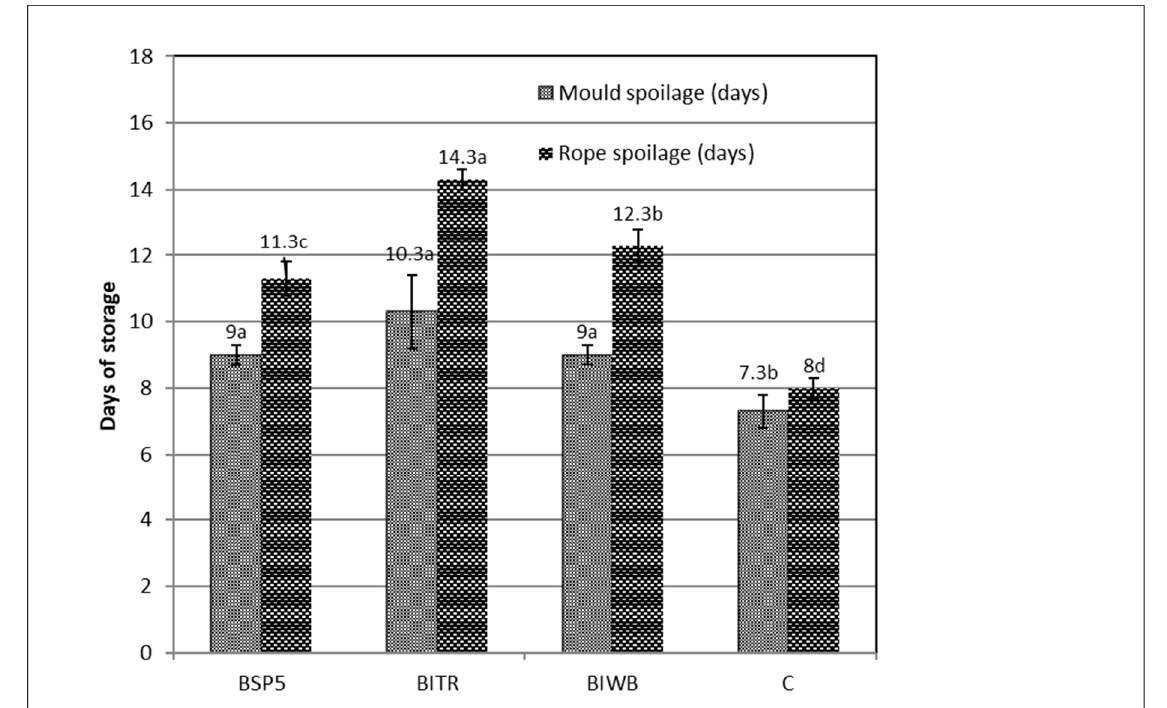
Figure 1. Appearance of rope and mould spoilage in the sourdough breads (BSP5: bread made with sourdough containing free, freeze-dried L. paracasei SP5 cells; BITR: bread made with sourdough containing ITR; BIWB: bread made with sourdough containing IWB; CB: control bread made with wild microflora sourdough. Similar lower-case letters in bars (groups for mould spoilage and groups for rope spoilage denote no significant differences at an alpha = 0.05 (ANOVA and Duncan post hoc multiple comparisons).